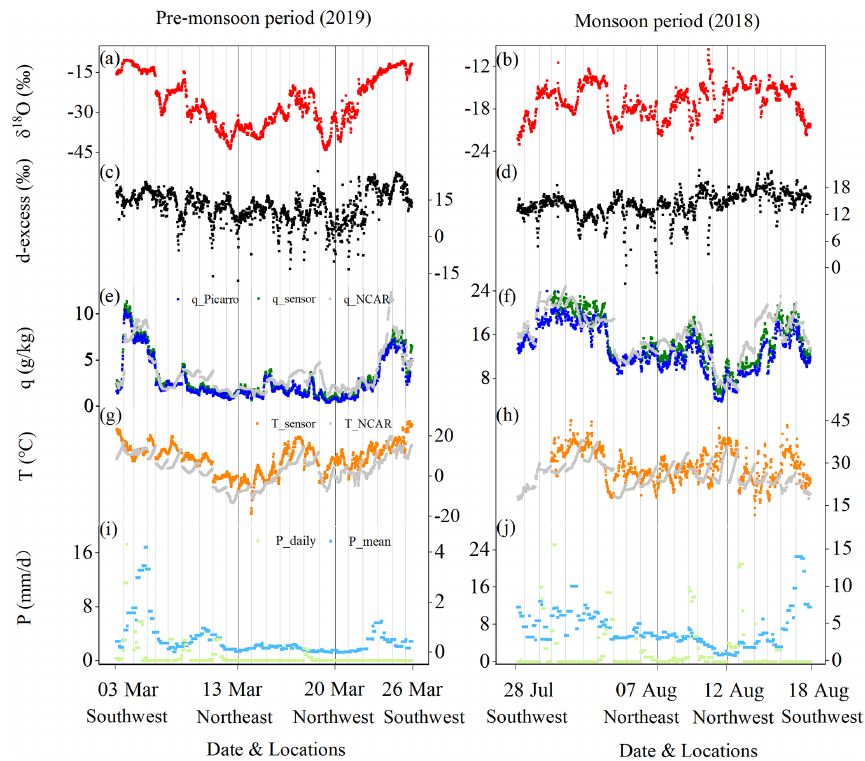
Figure 4. Measured vapor isotopic compositions and concurrent meteorological conditions along the survey routes during the pre-monsoon period (the left panel) and monsoon period (the right panel). (a, b) Vapor δ 18 O (‰); (c, d) vapor d-excess (‰); (e, f) specific humidity q (gkg − 1 ) measured by sensor (in green), measured by Picarro (in blue), and linearly interpolated from NCAR reanalysis (in gray); (g, h) air temperature T ( ◦ C) measured by Picarro (in orange) and linearly interpolated from NCAR reanalysis (in gray); and (i, j) the daily precipitation amount P daily (in green, mmd − 1 ) and average precipitation amount over the entire observation period of about 1 month for each observation location P mean (in blue, mmd − 1 ) extracted from GPCP. Note that the vertical gray lines space the observations for